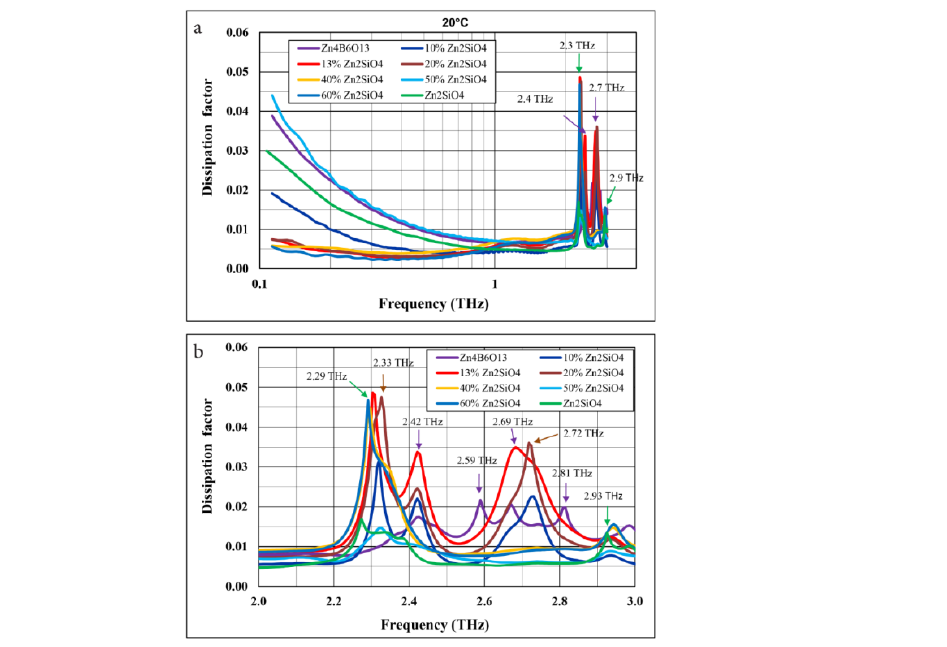
Figure 10. Comparison of dissipation factor at 20 °C as a function of frequency for Zn 4 B 6 O 13 , Zn 2 SiO 4 , and Zn 4 B 6 O 13 –Zn 2 SiO 4 ceramics: ( a ) a log-lin plot in the range 0.12–3 THz and ( b ) a more detailed lin-lin plot, in the range 2–3 THz.